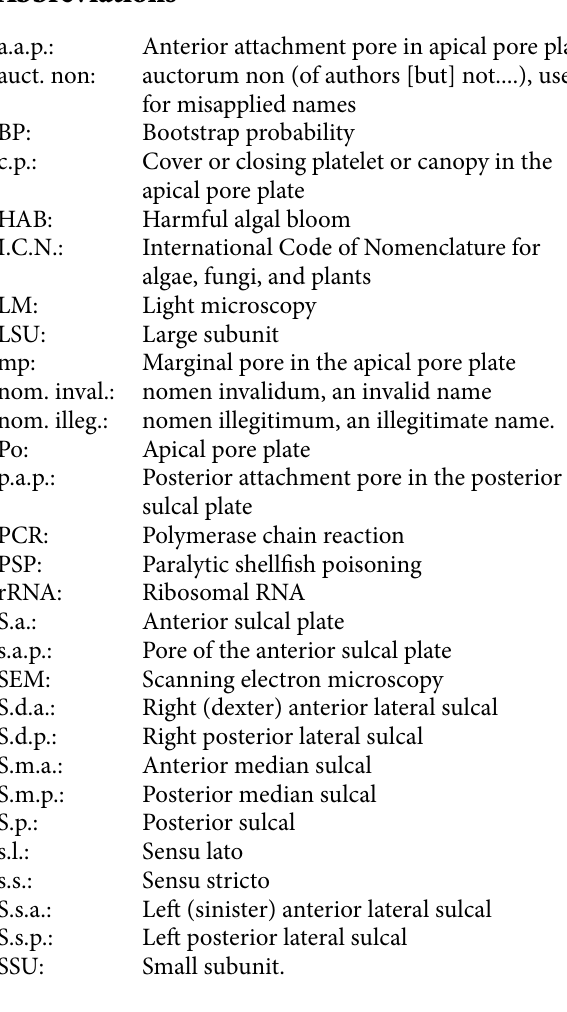
Supplementary 4 . Figure S1. Maximum-likelihood phy- logenetic trees of D1–D2 domains of the LSU rRNA